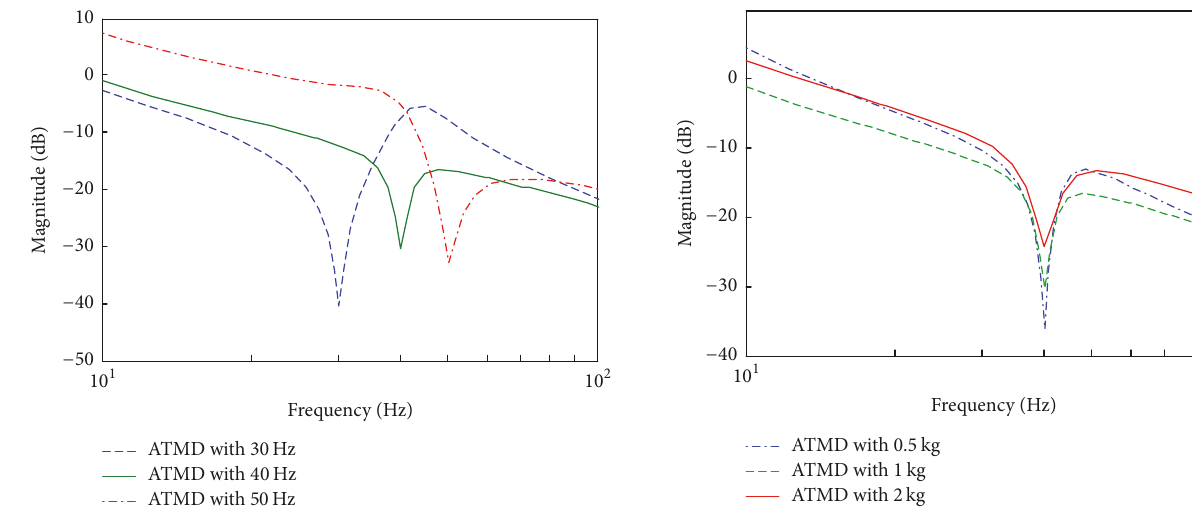
Figure 7: Needed active force of ATMDs of different mass.